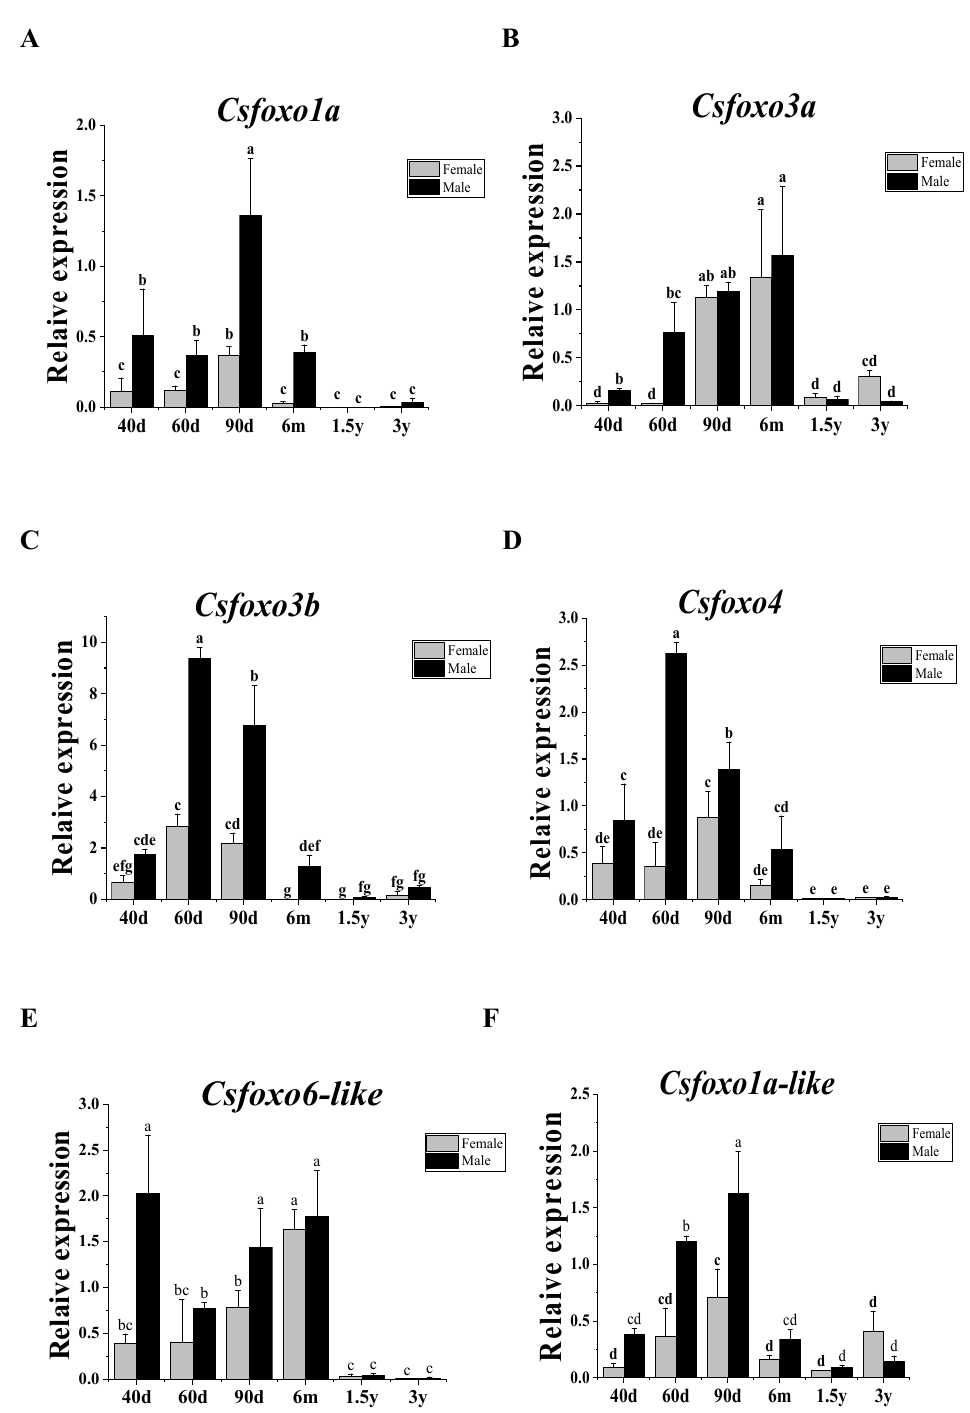
Figure 4. Expression patterns of Csfoxo in gonads at different developmental stages. ( A ) Expression patterns of Csfoxo1a at different developmental stages; ( B ) expression patterns of Csfoxo3a at differ- ent developmental stages; ( C ) expression patterns of Csfoxo3b at different developmental stages; ( D ) expression patterns of Csfoxo4 at different developmental stages; ( E ) expression patterns of Csfoxo6- like at different developmental stages; ( F ) expression patterns of Csfoxo1a-like at different develop- mental stages. The letters above each chart indicate significant differences, and the bars represent standard deviations.